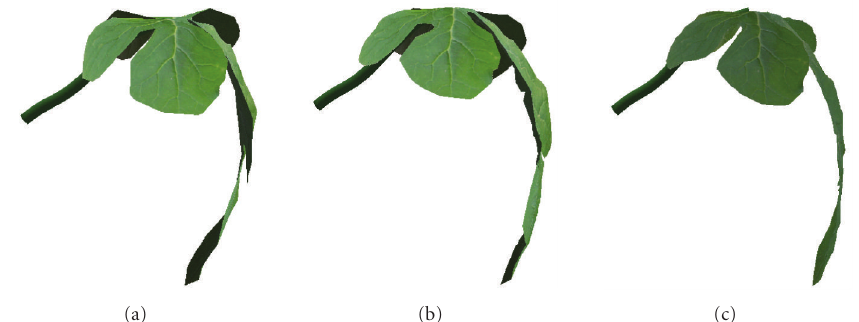
Figure 9: Comparison of modeling watermelon leaf with di ff erent parameters: (a) the parameters for segmenting the midveins is 10, iterations time is 0; (b) the parameters for segmenting the midveins is 20, iterations time is 1; (c) the parameters for segmenting the midveins is 30, iterations time is